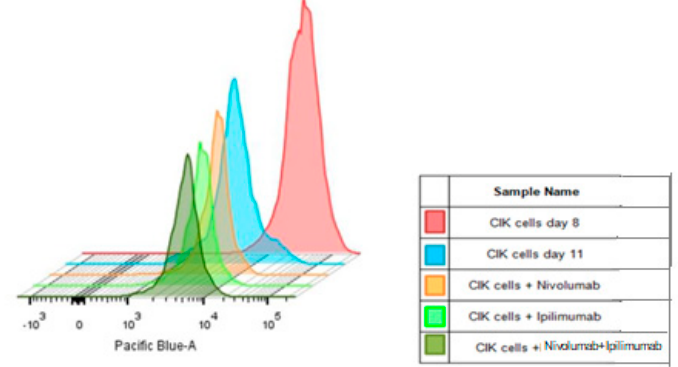
Figure 8. Effects of nivolumab and ipilimumab on proliferation of CIK cells labeled with CellTrace TM violet after 72 h treatment. CIK cells on day 8 were seeded into plates and were administered antibodies. After 72 h incubation, CIK cells on day 11 were harvested and analyzed by flow cytometry. The decrease of fluorescence in labeled CIK cells demonstrated the proliferation of CIK cells.